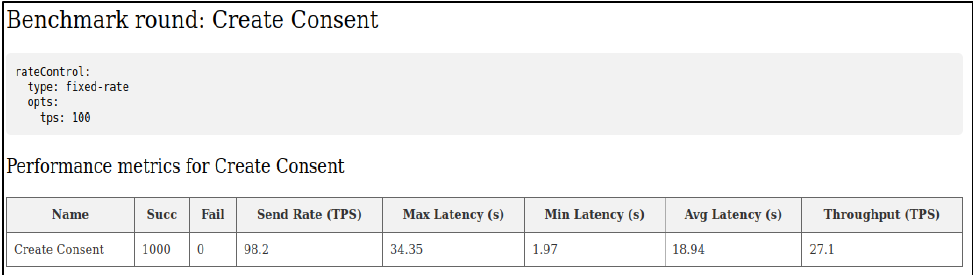
Figure 19. Caliper results (Create Consent) of experiment 3.